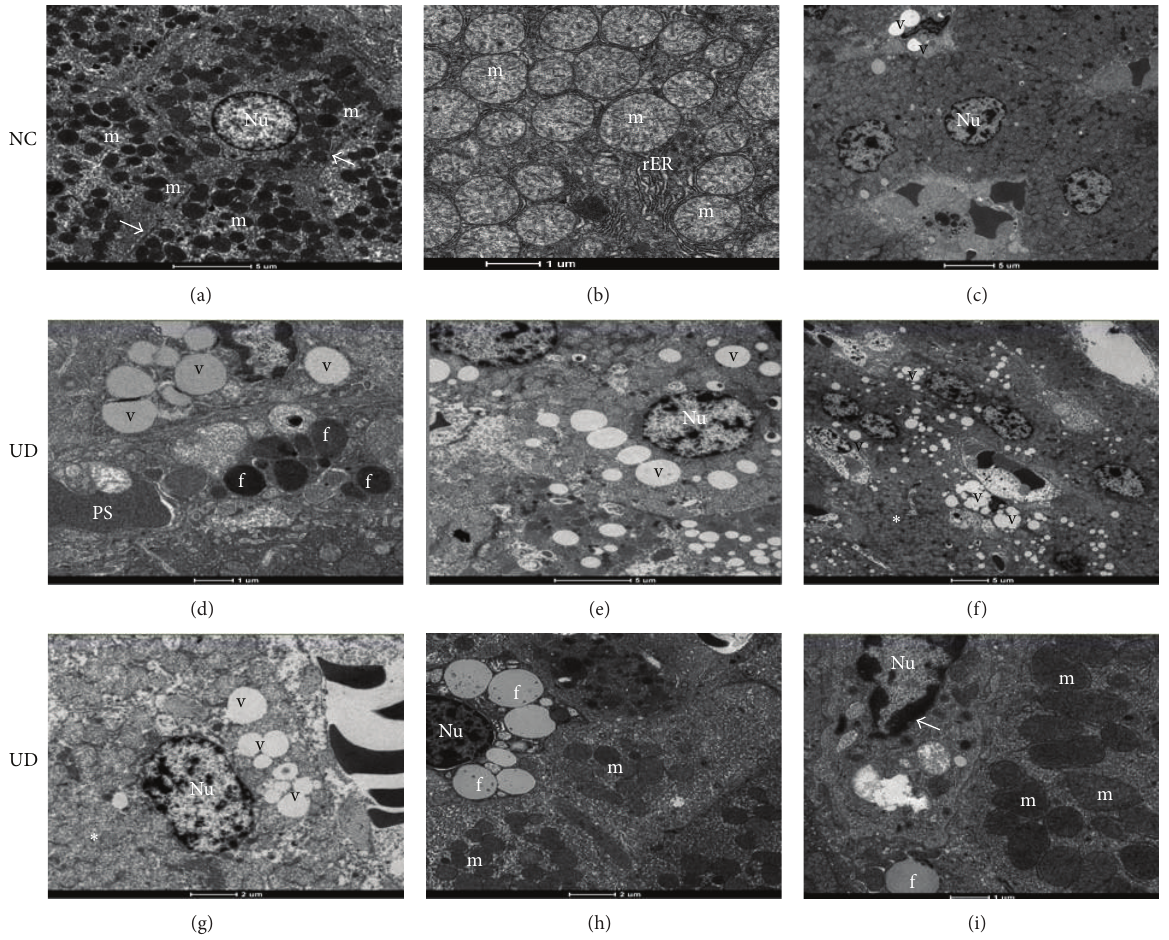
Figure 3: Electron micrographs of nondiabetic control rats (NC) sacrificed at 6, 14, and 26 weeks, respectively, showing (a) normal-appearing of hepatocytes, nucleus (Nu), mitochondria (m) and Disse’s space (arrows); (b) detail of mitochondria (m) and rough endoplasmic reticulum (rER)withtheirpreservedstructures;(c)focalareaoflipidvacuoles(v)inNCratsacrificedat26weeks(scalebars:(a),(c):1,900x;(b):4,800x). (d), (e), and (f): hepatocytes of untreated diabetic rats (UD) sacrificed at 6, 14, and 26 weeks, respectively, showing (d) hepatocyte showing moderate amount of lipid vacuoles (v) and hepatic lipid droplets (f); (e) worsening of liver fatty degeneration (v); (f) poor organization of the organelles within the cytoplasm with disappearance of the Disse’s space and rER ( ∗ ) with diffuse liver fatty degeneration (v) (scale bars: (d): 4,800x;(e),(f):1,900x).(g),(h),and(i):hepatocytesofUDratssacrificedat26weeksshowing:(g)intensedisorganizationofcellultrastructure ( ∗ ); (h) scarce amount of mitochondria (m) within the cytoplasm; (i) mitochondria appear larger, less electron-dense with less distinct cristae (m). Note the condensation of nuclear chromatin (arrow) (scale bars: (g), (h), (i): 4,800x).